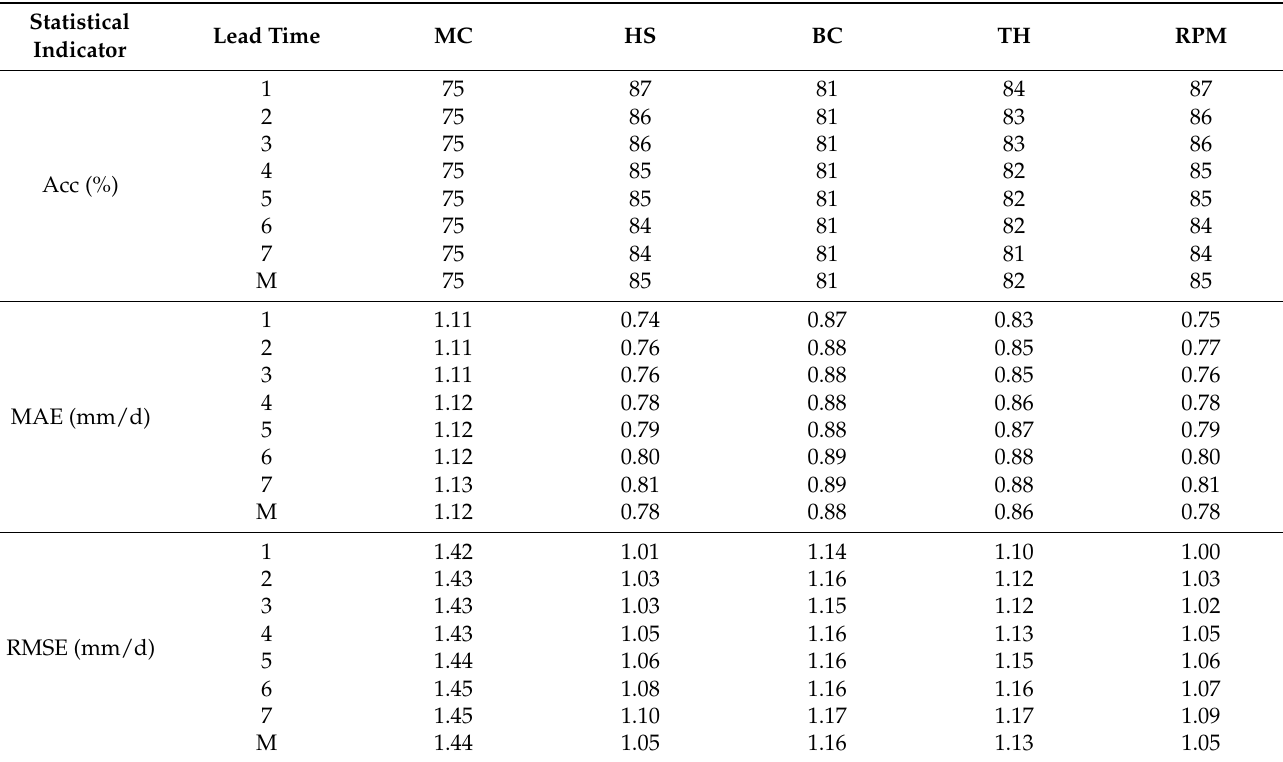
Table 5. Average values of the statistical indicators of five temperature-based models’ ET 0 forecast accuracy for 17 stations in 1–7 d ahead forecasts for the